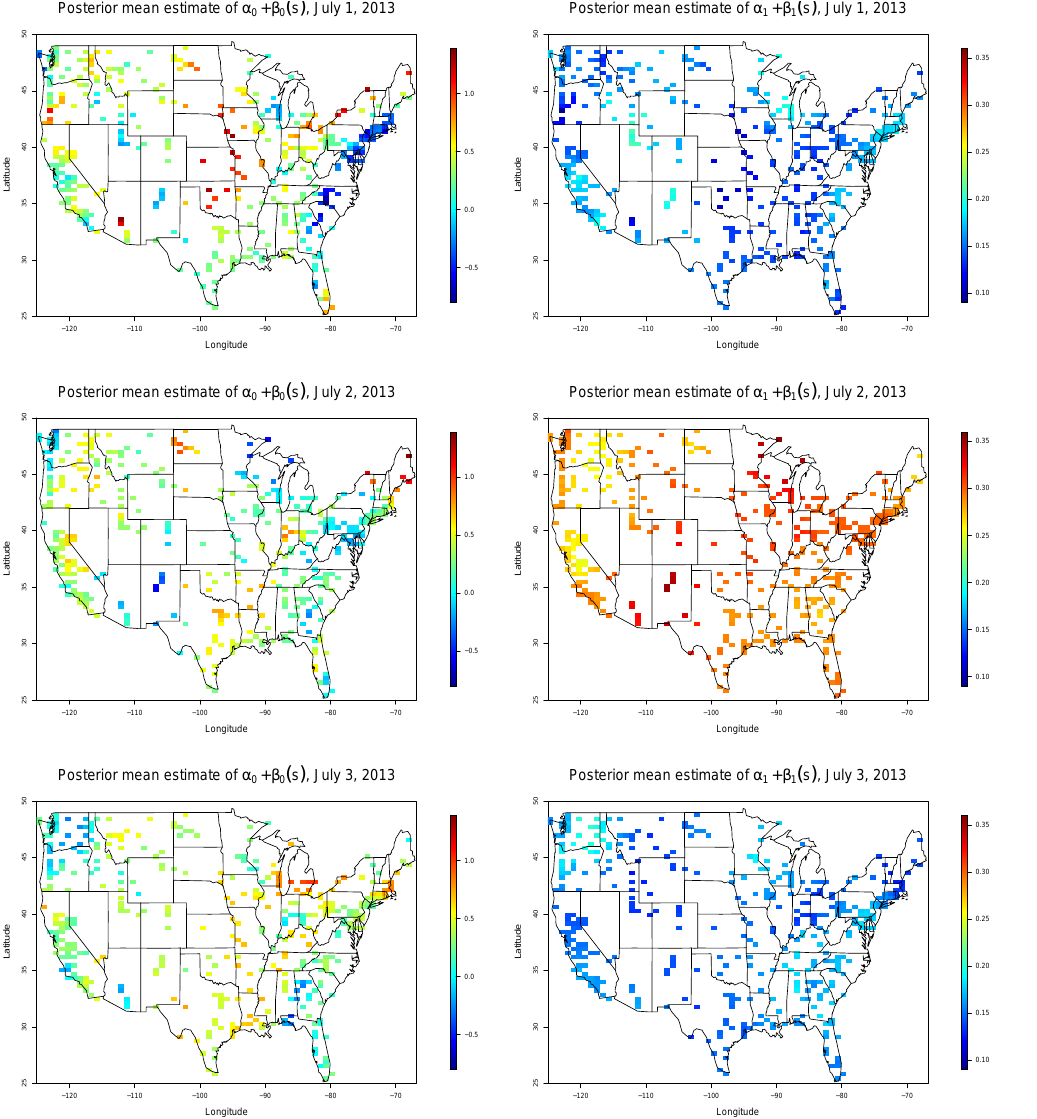
Figure 10. Posterior mean estimates of the coefficients, α 0 + β 0 ( s ) and α 1 + β 1 ( s ) for 3 consecutive days from Eq. (2).